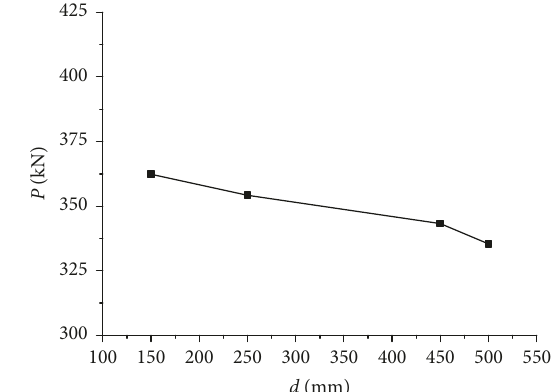
Figure 13: Relationship between shear stud spacing and shear